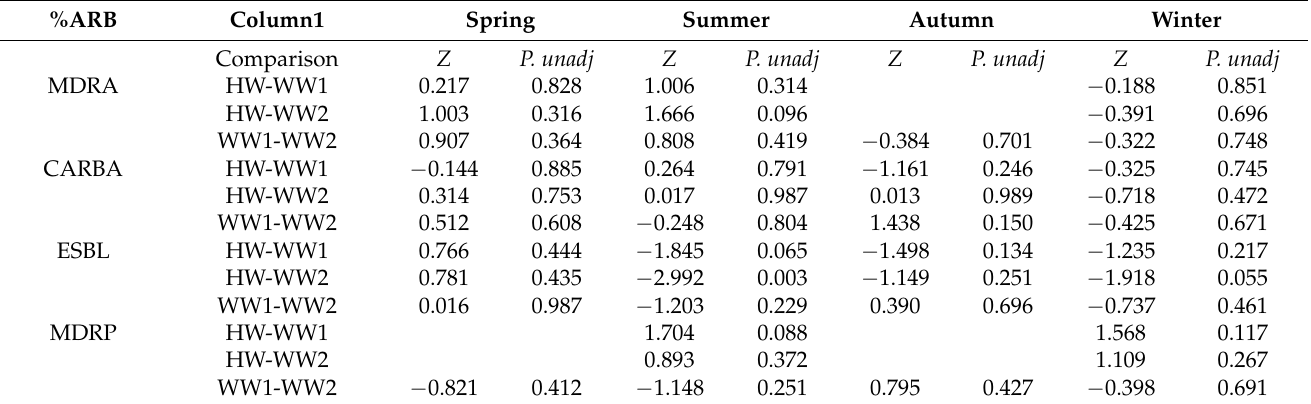
Table A1. Z scores and p values from Dunn test for pair comparisons with Bonferroni